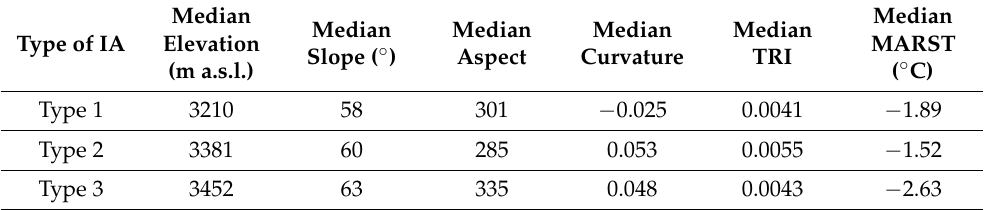
Table 5. Statistical analysis of the IA types with different topographic